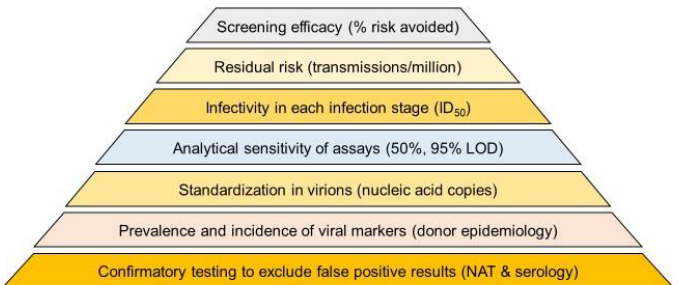
Figure 1. Foundations for estimating efficacy of different screening scenarios in removing viral transmission risk. The prevalence and incidence of HBV infections can only be reliably established if false-positive results in NAT and serologic assays are excluded by confirmatory testing. Since one virion in a blood component can be enough to cause transmission, it is important to standardize NAT and 50% infectious dose (in different infection stages) in virion or nucleic acid copy numbers. The residual risk of a testing scenario can then be estimated using infectivity-based mathematical models published by Weusten et al. [4,10]. Likewise the efficacy in reducing transmission risk can be estimated as a percentage relative to the baseline risk that would exist without using any screening test.